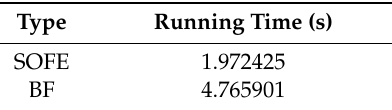
Figure 12. Simulation results of sequential analysis and inverse covariance intersection ‐ global state fusion estimation (SICI ‐ GSFE) algorithm.